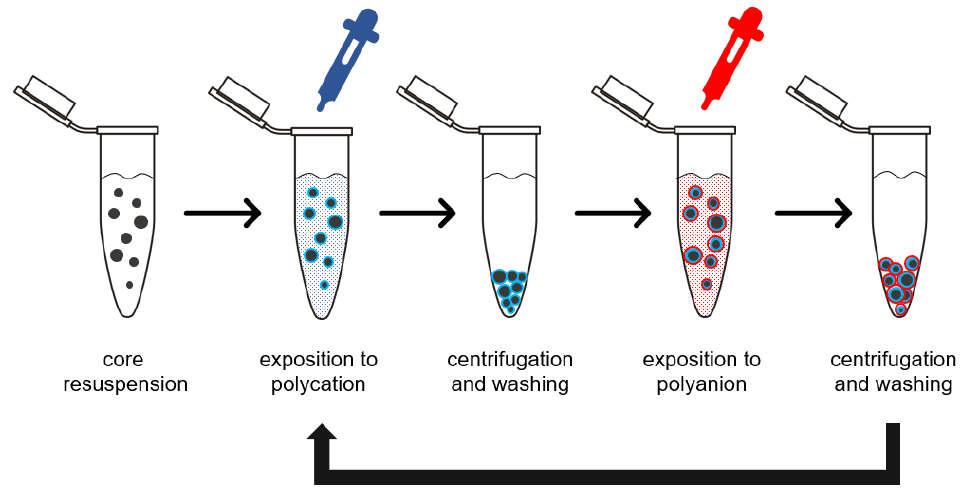
Figure 1. Schematic representation of layer-by-layer coating assembly on microparticle surface.